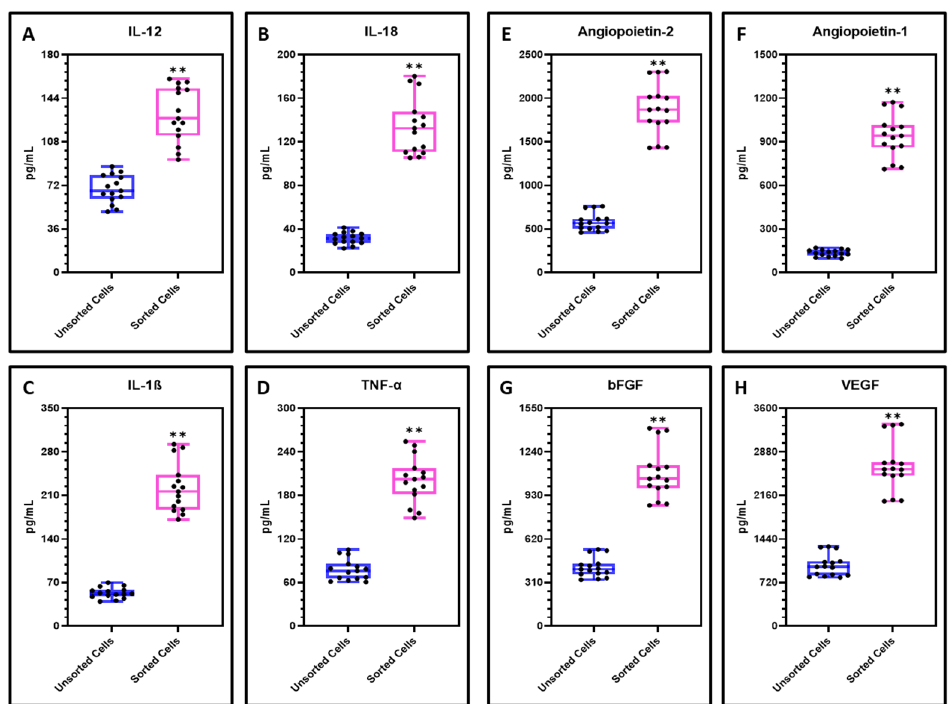
Figure 4. Analysis of cytokines and angiogenic factors in the secretome of OSCC cells by ELISA. ( A – D ) Comparative cytokine analysis of inflammatory cytokines IL-12, IL-18, IL-1ß, and TNF- α in the secretomes of OSCC cells and sorted CD44+ cells; ( E – H ) Comparative growth factor analysis of angiogenic factors Angiopoietin-2, bFGF, Angiopoietin-1, and VEGF in the secretomes of OSCC cells and sorted CD44+ cells. Experiments were performed in triplicates for all five samples independently. ns not significant, ** p < 0.01 .